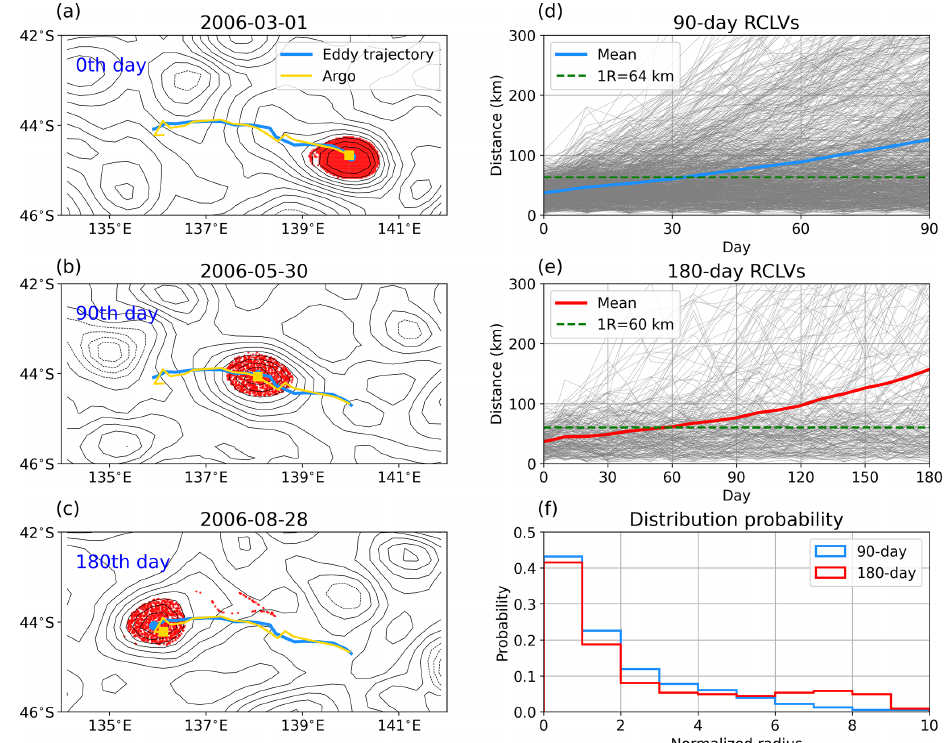
Figure 9. (a–c) A case showing that an Argo float is trapped by a 180d RCLV (red dots), with the SLA field overlaid in black contours. The blue line tracks the eddy center’s trajectory, while the yellow line tracks the Argo float’s trajectory. (d,e) The distance between eddy centers and Argo floats that are initially trapped during the eddy lifetime for 90 and 180d RCLVs. Thin gray lines indicate the ensemble, and the thick blue (red) line is the mean of 90d (180d) RCLVs. The green dashed line is the average radius of RCLVs. (f) The distribution probability of Argo floats with respect to the normalized eddy radius at the final times for 90d (blue line) and 180d (red line)